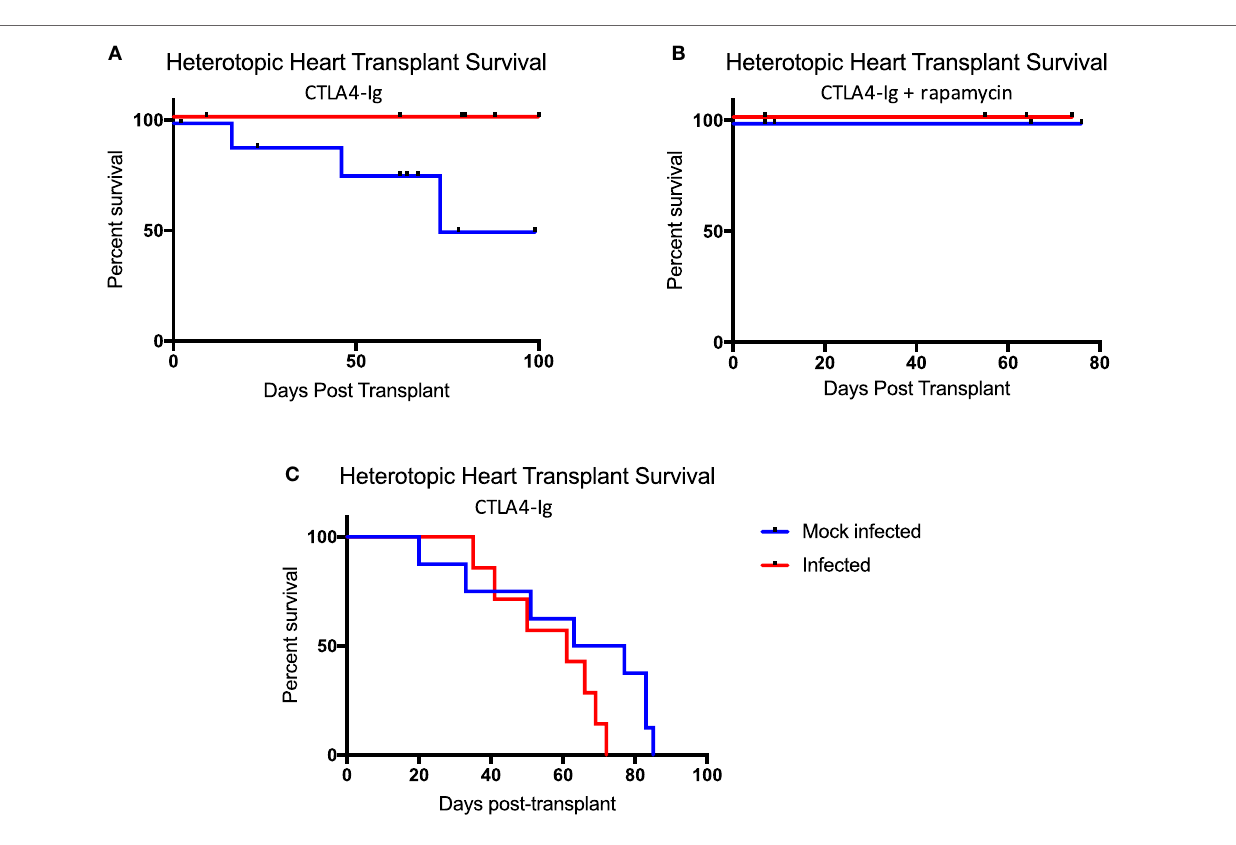
FigUre 6 | Latent and persistent viral infection does not impact allograft rejection in the setting of costimulation blockade (CoB). (a) Mice infected with polyomavirus, murine cytomegalovirus, and HV68 ( n = 12) under chronic CoB with CTLA4-Ig fail to reject their allograft, while mock-infected mice ( n = 10) do go on to reject their allograft ( p = 0.0258). (B) No difference in allograft survival was observed between infected ( n = 4) and mock-infected ( n = 4) mice under chronic immunosuppression with CTLA4-Ig and rapamycin ( p > 0.9999). (c) When treated with short course CTLA4-Ig, survival curves were not significantly different between infected ( n = 7) and mock-infected ( n = 8) mice ( p = 0.1174). Decrement survival indicates immunosuppressive death with a functioning allograft. Allograft survival data were assessed using the Log-rank (Mantel–Cox) test for statistical significance.